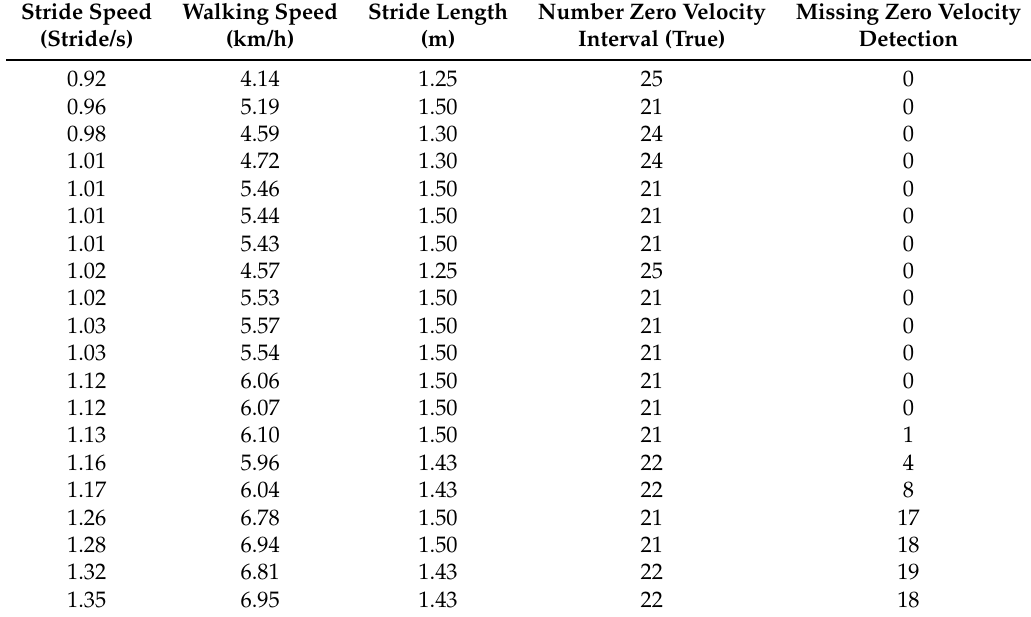
Table 4. Zero velocity detection with different walking